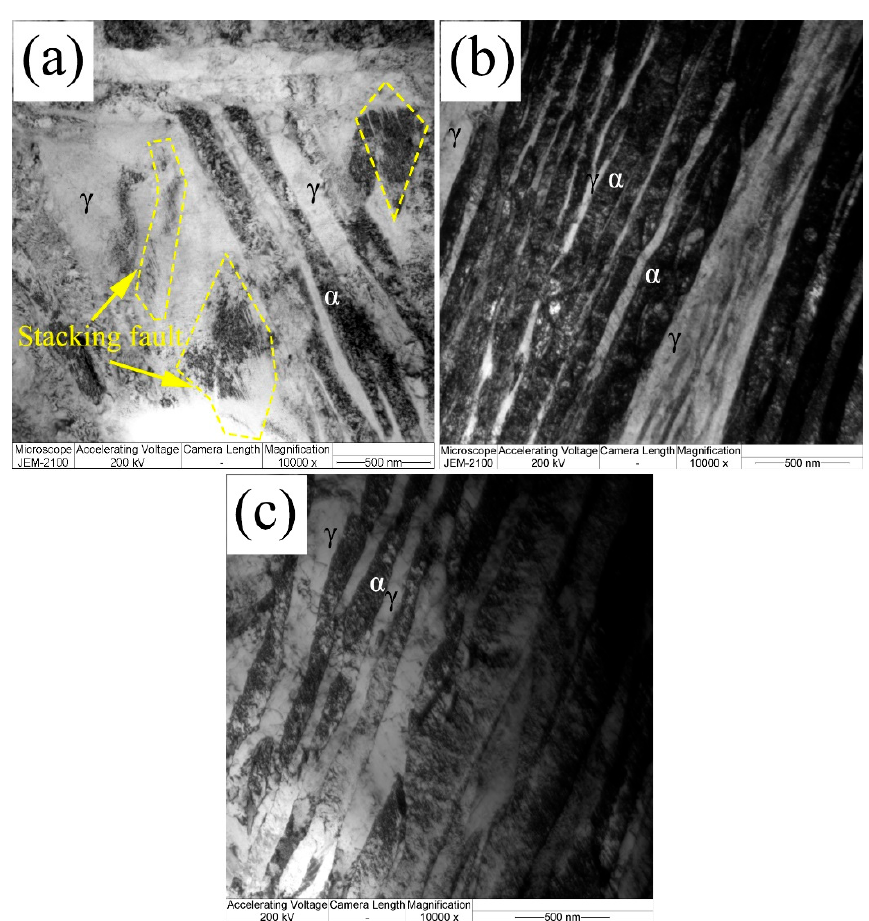
Figure 7. Typical TEM micrograph of the bainite transformed at ( a ) 200 °C, ( b ) 250 °C, and ( c ) 300 °C.